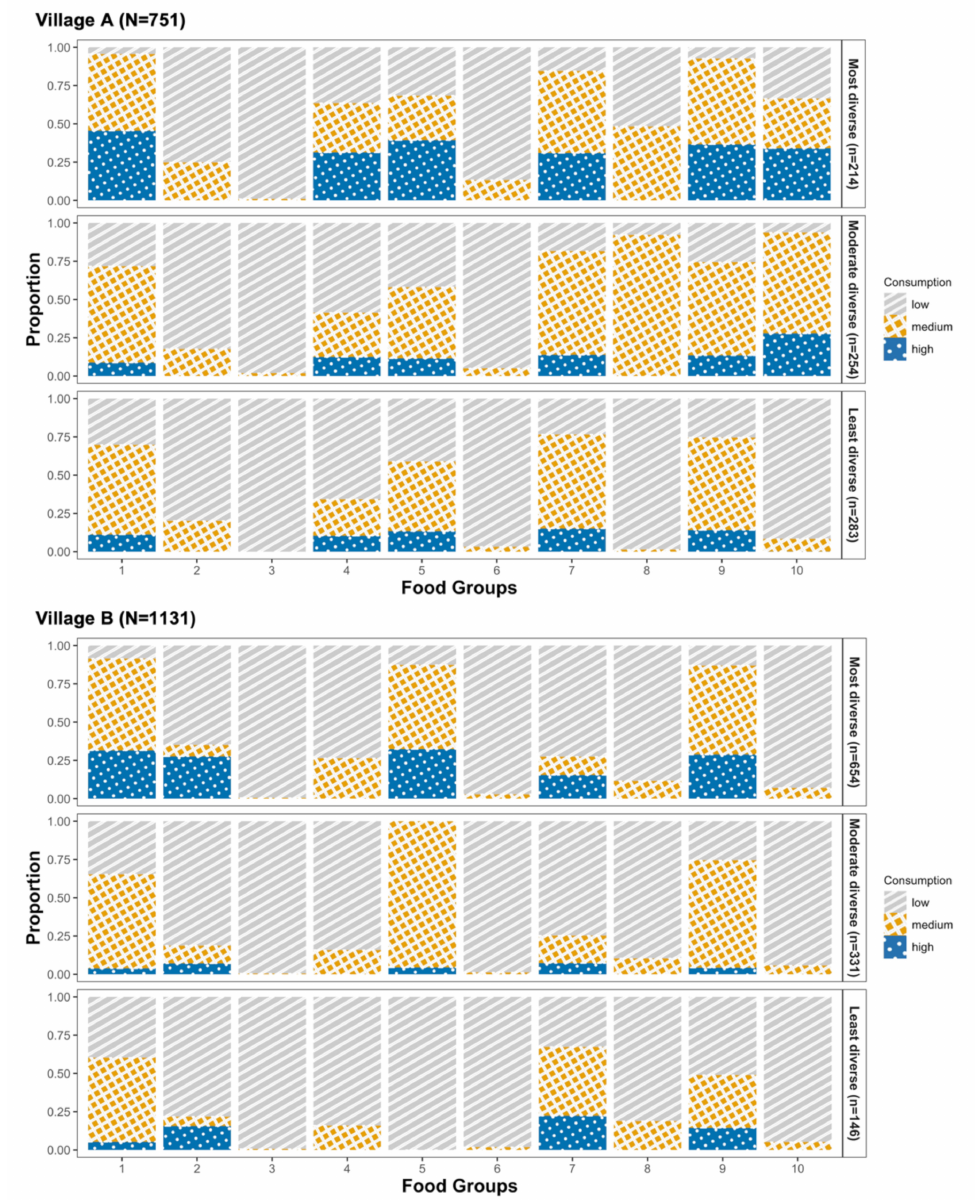
Figure 2. Dietary patterns in children in village A ( upper ) and village B ( lower ) in western Kenya. The horizontal axis corresponds to food groups: (1) grains, white roots and tubers, and plantains; (2) pulses (beans, peas, and lentils); (3) nuts and seeds; (4) dairy; (5) meat, poultry, and fish; (6) eggs; (7) dark green leafy vegetables; (8) other Vitamin A-rich fruits and vegetables; (9) other vegetables; and (10) other fruits. The vertical axis is the prevalence of children consuming a low, medium, and high amount of each food group within each dietary